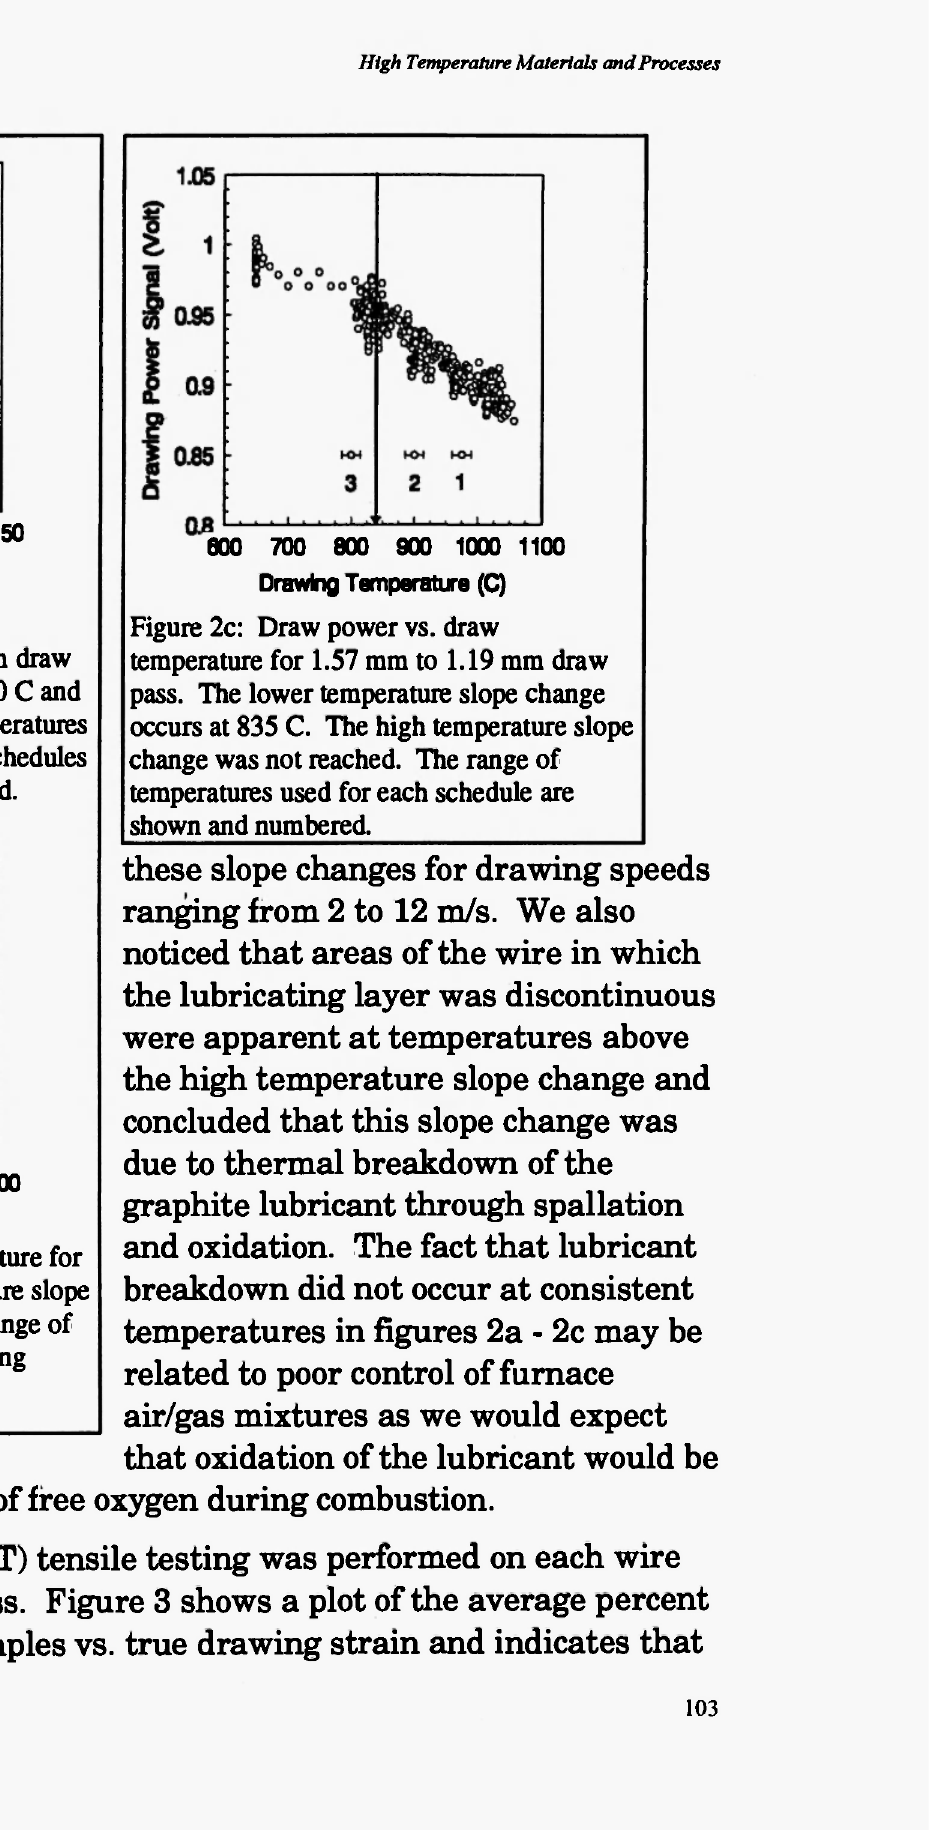
Figure 2b: Draw power vs. temperature for 2.08 to 1.57 mm draw pass. There are slope changes at 920 C and 975 C. The range of temperatures used in the three drawing schedules are shown and numbered.